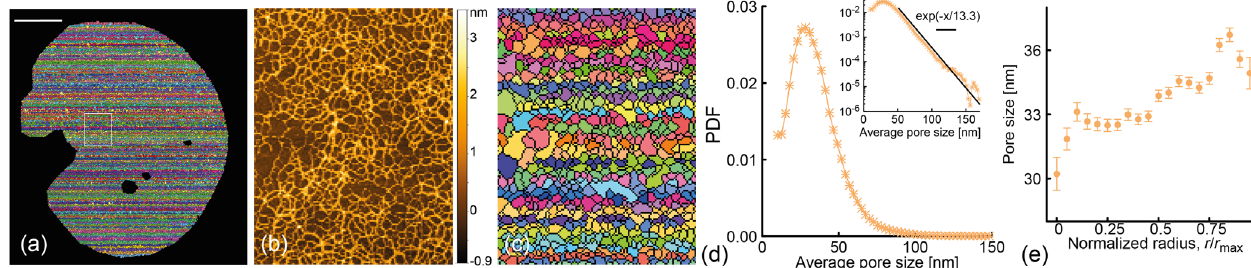
FIG. 5. (a) Morphological segmentation of the AFM image show in Fig. 1(a). The scale bar is 1 μ m. (b) An enlarged region showing side by side the AFM picture and in (c) the result of morphological segmentation. (d) Probability density function (PDF) of mesh size. The inset shows a log-linear plot of the same PDF, with an exponential decay reported as a guide for the eye. (e) Average pore size as a function of the radial distance from the center of the